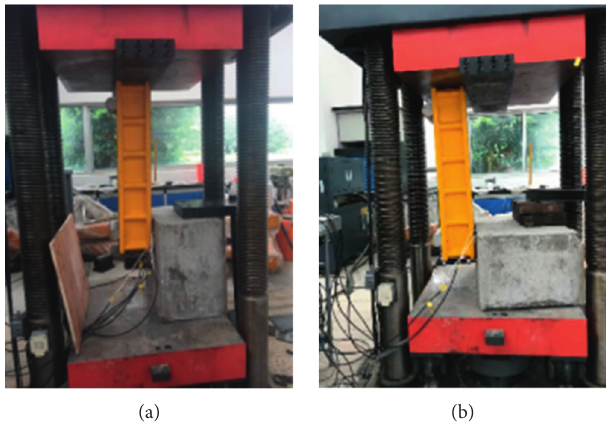
Figure 3: The built-in fitting for (a) plate-type and (b) slot-type.